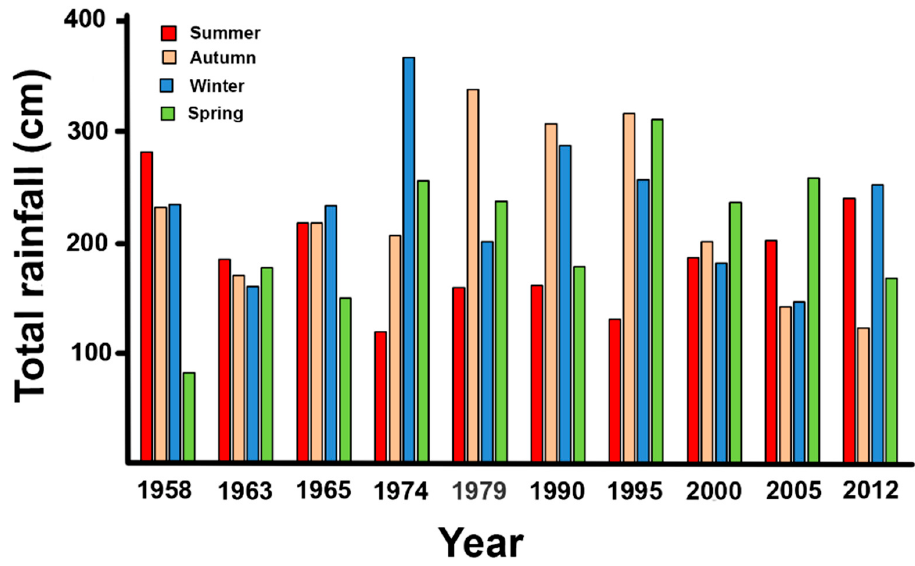
Figure 8. Total rainfall by season and by (non-sequential) year of the images of the study sites.